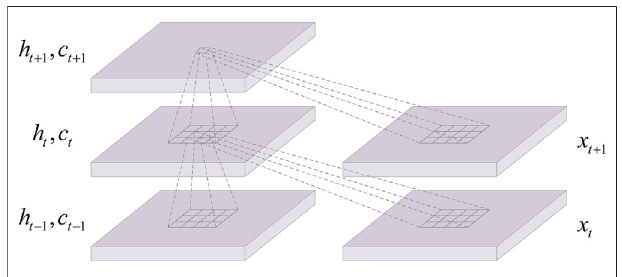
FIGURE 1 | Inner structure of